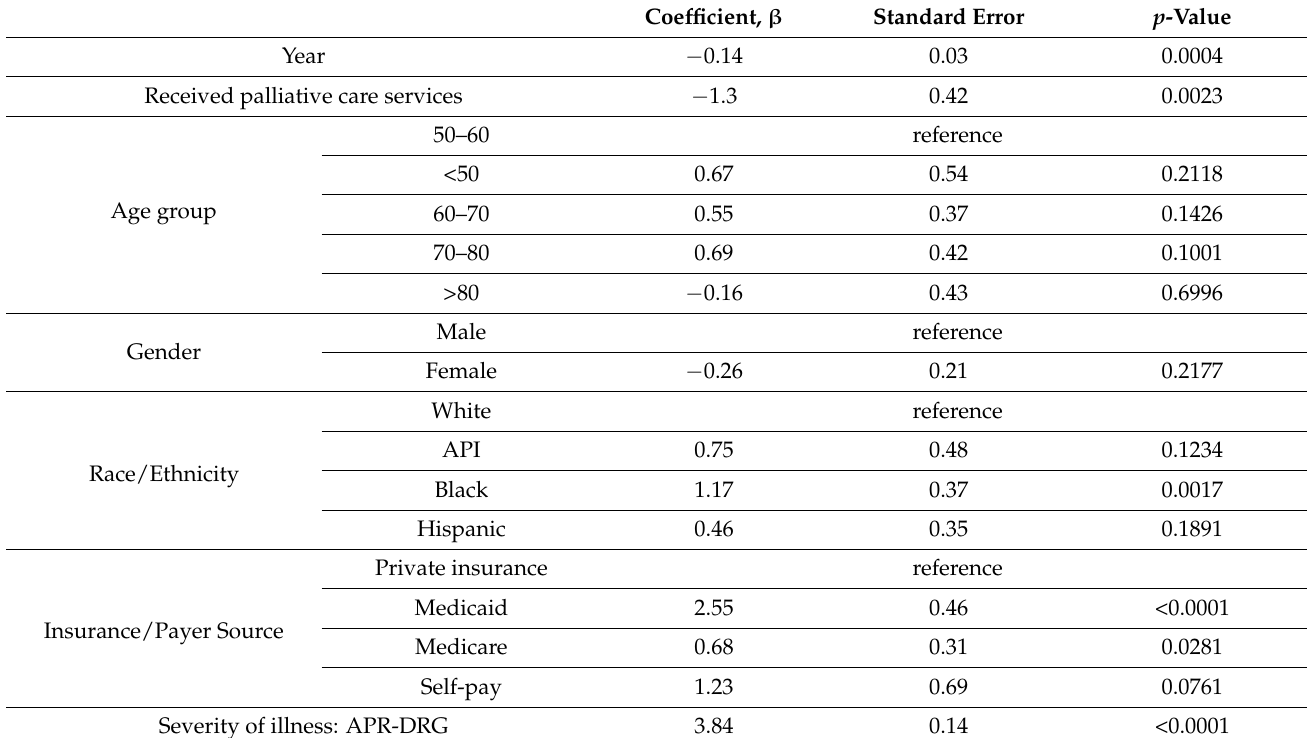
Table 3. Factors associated with LOS (length of stay) in ECC in US hospitals from 2007 to 2016. NIS